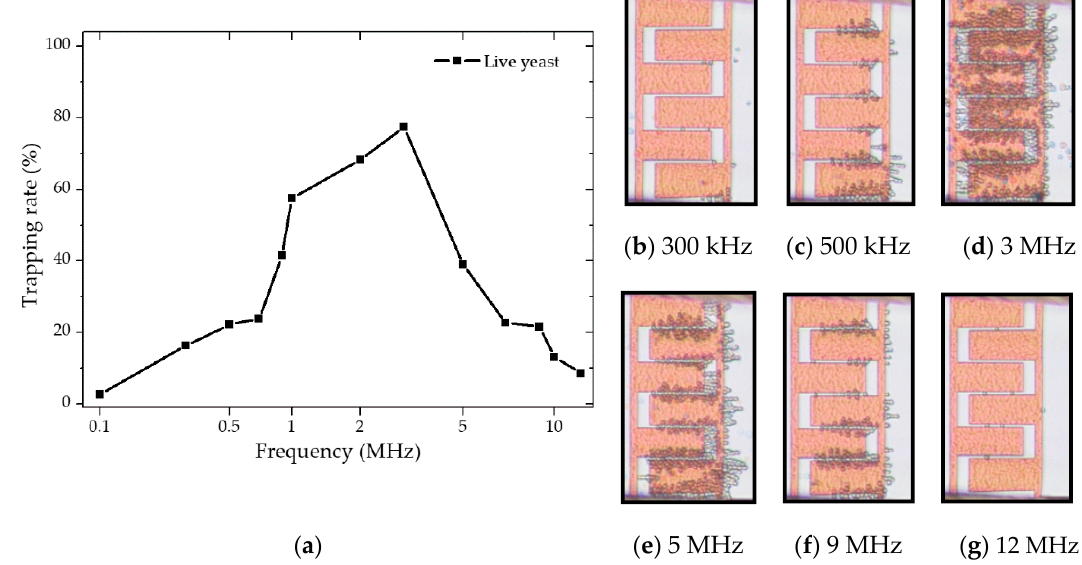
Figure 6. DEP characterization of live yeasts in DIW at 1 µm s − 1 flow rate: ( a ) Trapping rate (yield) approximation by changing frequency based on covered cell area at the IDEs; ( b – g ) the images show the trapping at various frequencies after 1 min.